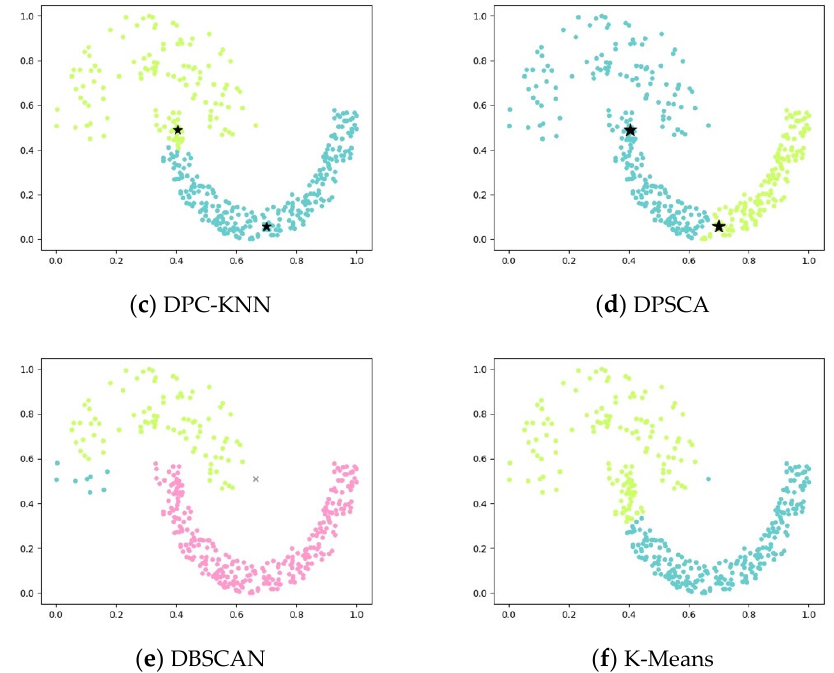
Figure 5. Clustering results on the Jain dataset.